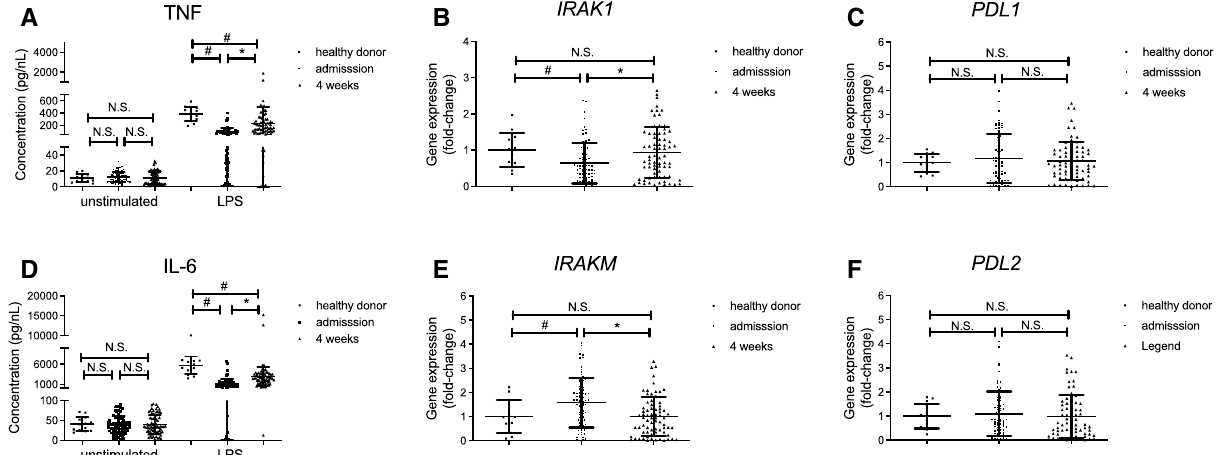
Figure 2. Peripheral CD14 + CD16 − monocytes from alcohol-dependent patients produce less TNF-α and IL-6 after in vitro stimulation with LPS, and the defect is partially recovered following alcohol abstinence for 4 weeks. ( A , B ) Concentration of TNF-α ( A ) and IL-6 ( B ) in the culture supernatants of CD14 + monocytes isolated from each individual in the indicated groups stimulated with medium or LPS for 24 h in vitro. Data represent the mean ± SD. ( C – F ) Gene expression of ( C ) IRAK-1 , ( D ) IRAK-M , ( E ) PD-L1 , and ( F ) PD-L2 in peripheral blood mononuclear cells (PBMCs) isolated from each individual in the indicated groups. Data represent the mean ± SD. # p < 0.05 by Student’s unpaired t-test. N.S.: not